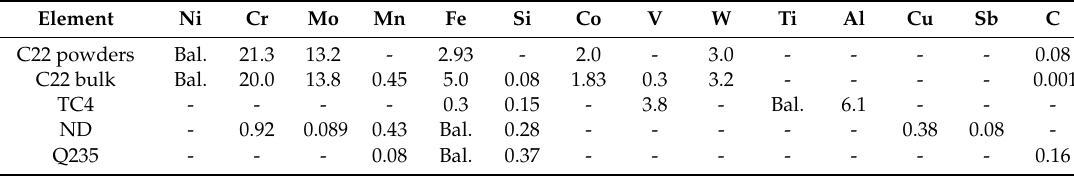
Table 1. Chemical compositions of C22 powders, C22 bulk, TC4, ND, and Q235 in wt.%.